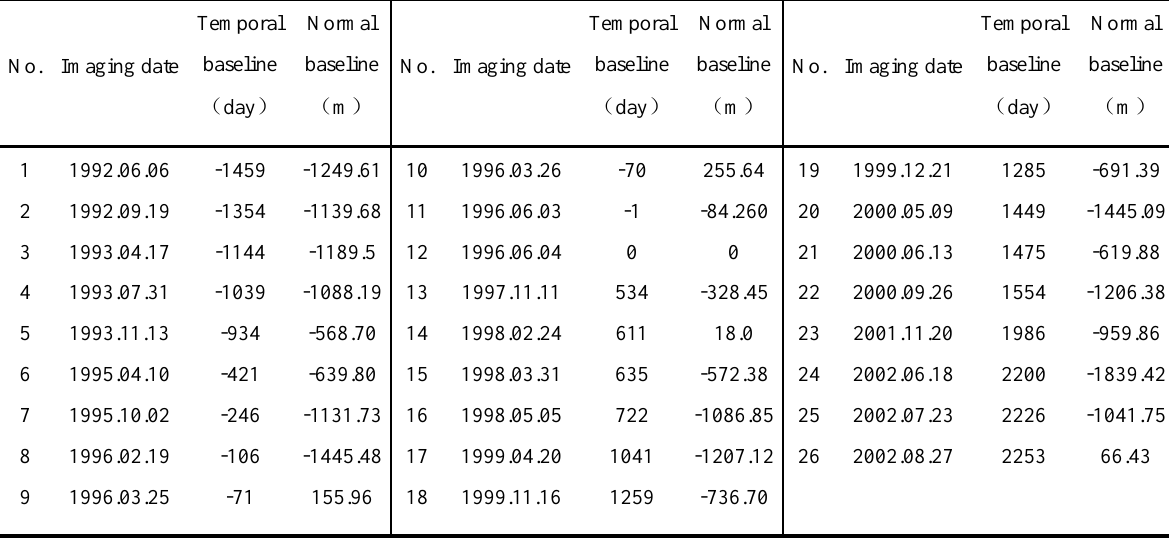
Figure 7. Projection of three-dimensional network on Figure 6. Two-dimensional Delaunay two-dimensional plane in study area network based on the Table 1. The parameters of 26 ERS-1/2 SAR images used in this study.